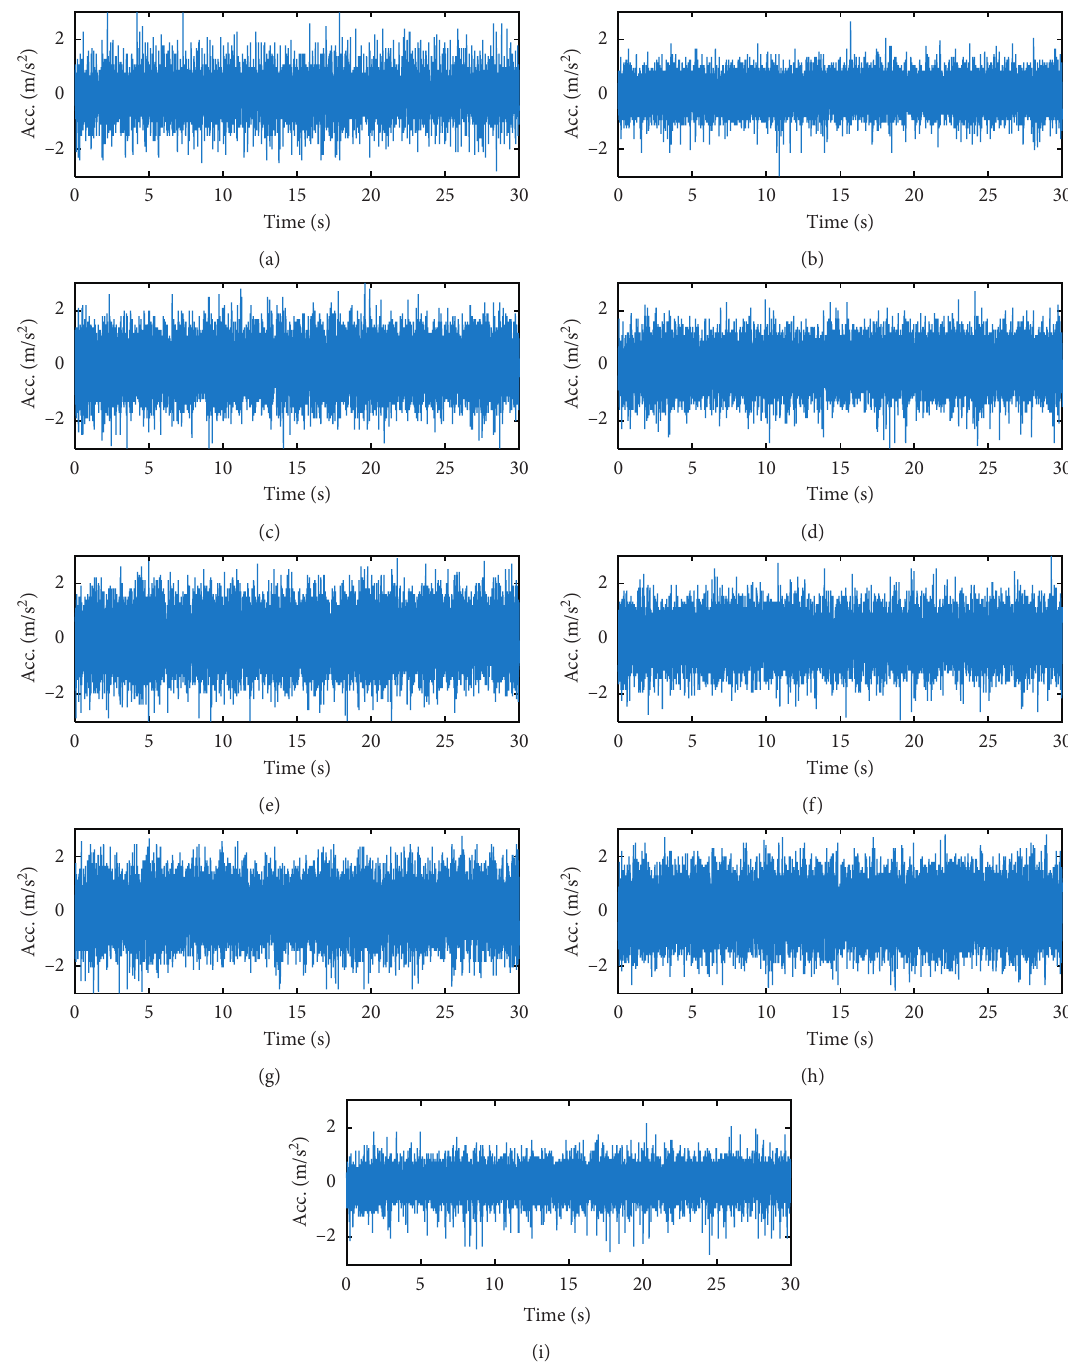
Figure 5: Time history of vibration data recorded by the MEMS accelerometer mounted on the CSD system. (a) Fault no. 1. (b) Fault no. 2. (c) Fault no. 3. (d) Fault no. 4. (e) Fault no. 5. (f) Fault no. 6. (g) Fault no. 7. (h) Fault no. 8. (i) Figure 6. The peaks under 500 Hz are related to the rotating (vii) Structural dynamic resonance of the CSD system: frequency of the shaft, the teeth meshing frequency, the 57 Hz contact frequency of balls in bearings, and the contact The frequencies have several vibration peaks corre- frequency between chain and sprocket. The high frequency sponding to these sources, as shown in Figure 6. The fre- peaks are related to mechanical faults such as broken teeth, quency region of these vibration peaks is under 500 Hz. The bearing wear, and rotating shaft imbalance. The mutual variations in vibration caused by the eight faults primarily spectrum shapes of the eight fault signals were also different. occur in the frequency region above 500 Hz, as shown in